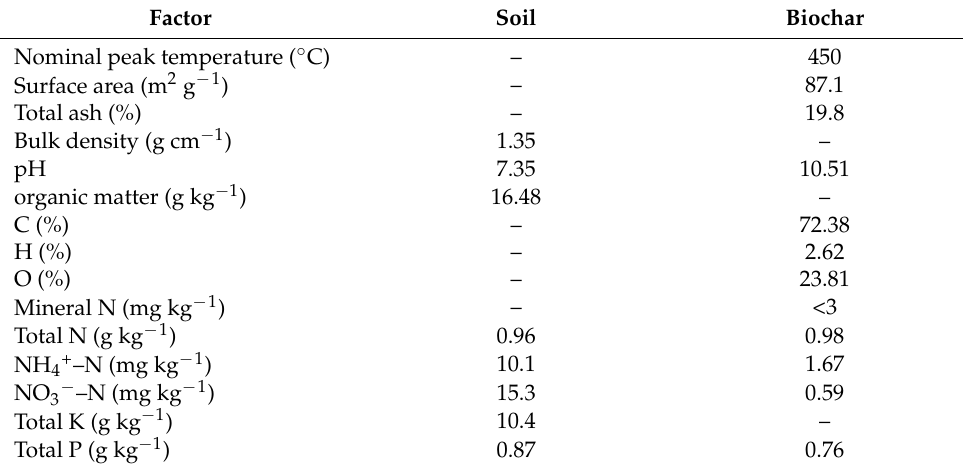
Table 1. Soil and biochar properties.